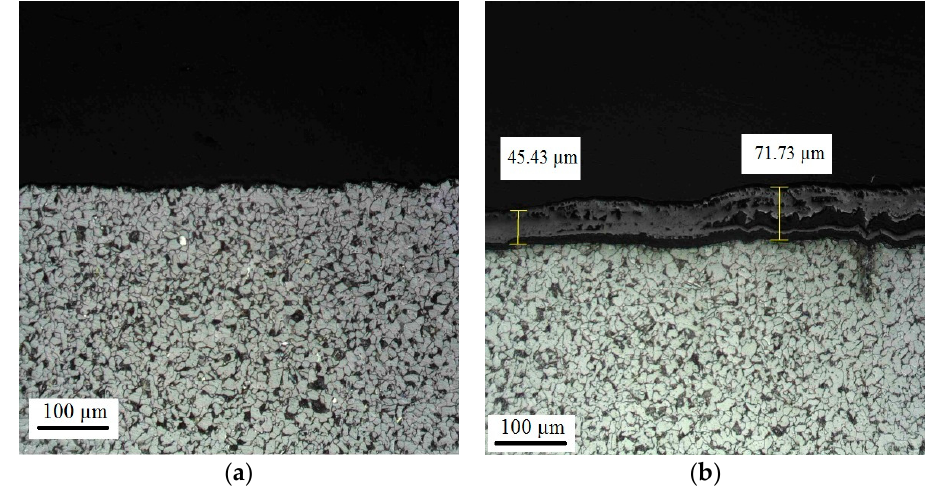
Figure 4. Microstructure images of the cross-section of CS-Bare ( a ) before, and ( b ) after the high-temperature corrosive attack after 168 h.